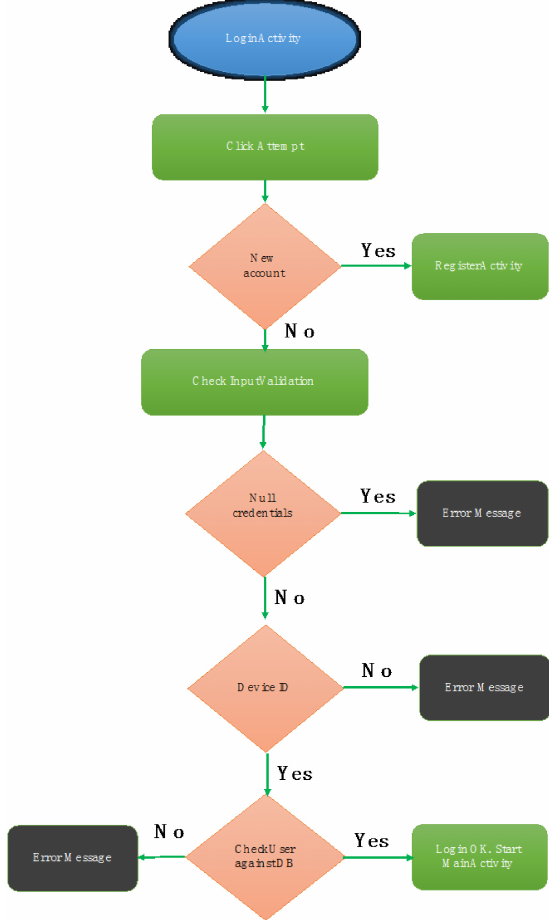
Figure 11. Start procedure flow-chart.